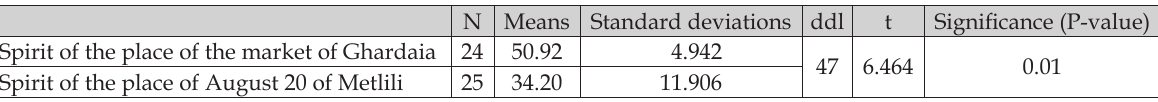
Table 7. The difference between the score means of the spirits of Market place of Ghardaïa and the place of August 20 of Metlili.